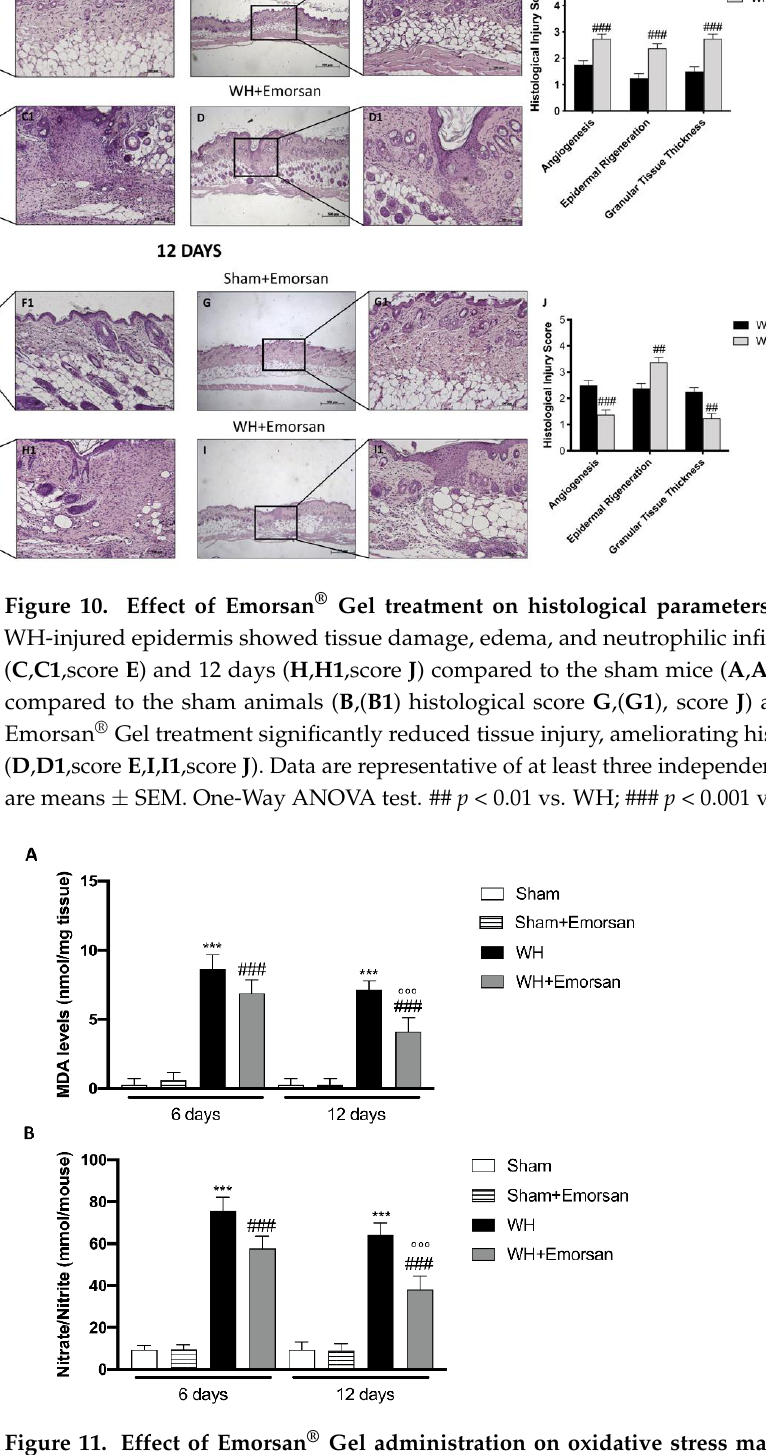
Figure 11. Effect of Emorsan ® Gel administration on oxidative stress markers after wound induc- tion . Topical treatment with Emorsan ® Gel diminished MDA levels both on day 6 and day 12 after wound induction ( A ). Likewise, nitrate/nitrite levels were significantly decreased after Emorsan ® administration ( B ). Data are representative of at least three independent experiments. Values are means ± SEM. One-Way ANOVA test. *** p < 0.001 vs. corresponding Sham; ### p < 0.001 vs. corre- sponding WH; °°° p < 0.001 vs. WH+Emorsan 6 days.